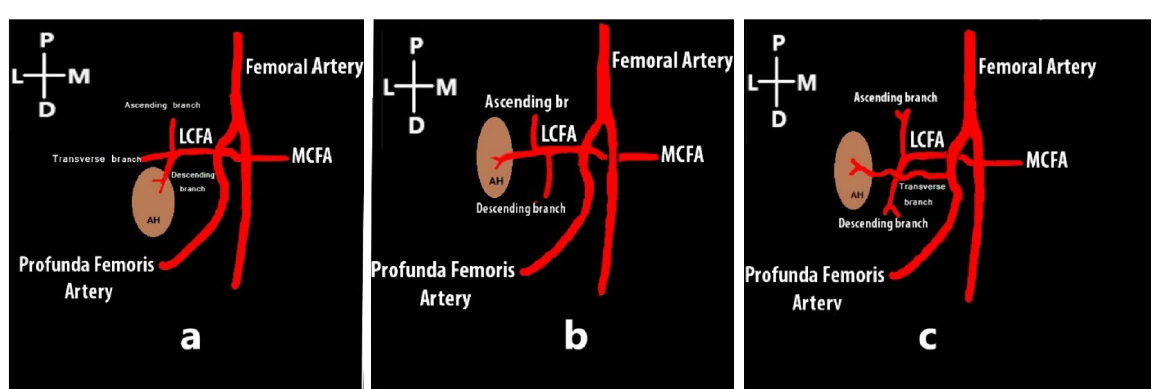
Figure 6. Schematic diagram showing the arterial supply to the additional muscle head; LCFA—lateral circumflex femoral artery, MCFA—medial circumflex femoral artery, AH—additional muscle Radiological study.